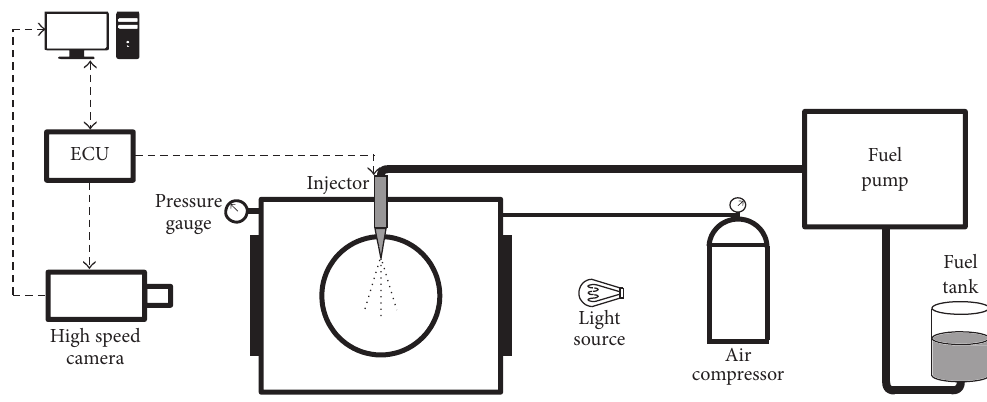
Figure 2: Schematic layout of the spray test rig.